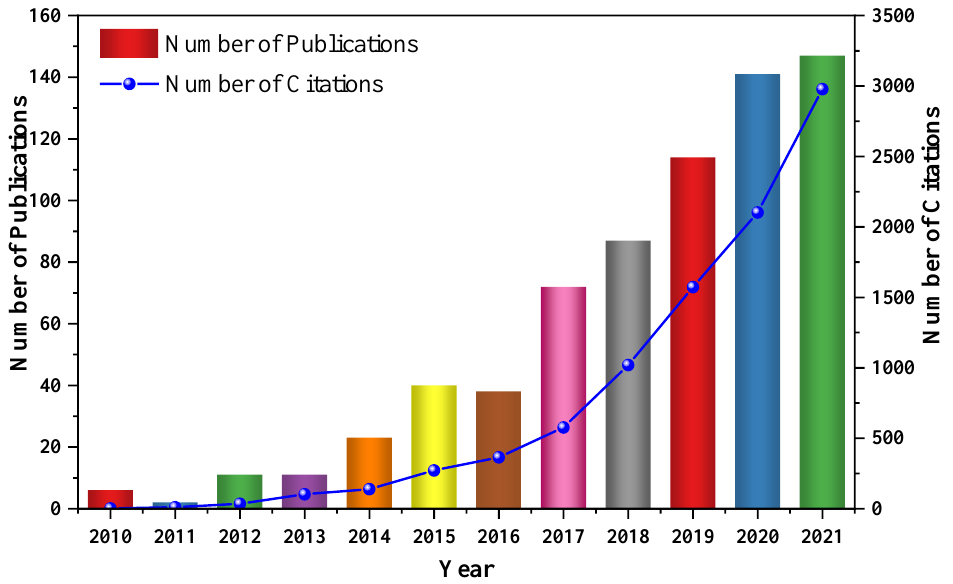
Figure 3. Number of publications and citations from 2010 to 2021 in China.